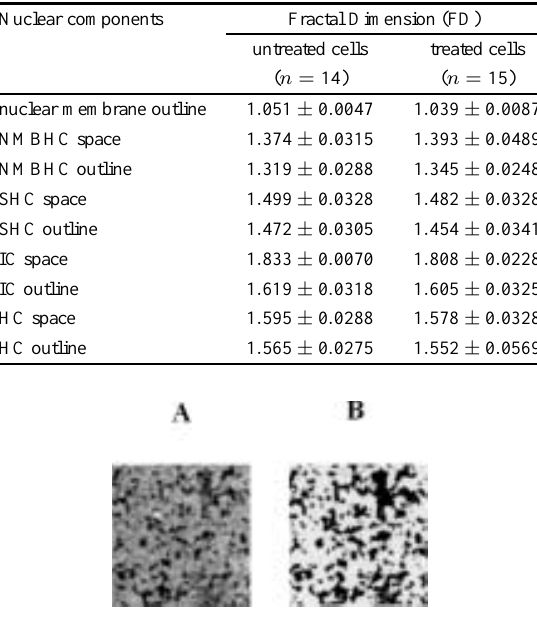
Fig. 3. A: EM view of ROI (magnification × 10580) identified on nuclei of untreated SK-BR-3 cells. B: view of nuclear ROI from Fig. 3A segmented by grey level threshold method. Black regions correspond to scattered heterochromatin (SHC) and white regions to inter(eu)chromatin (IC). ROI dimensions are